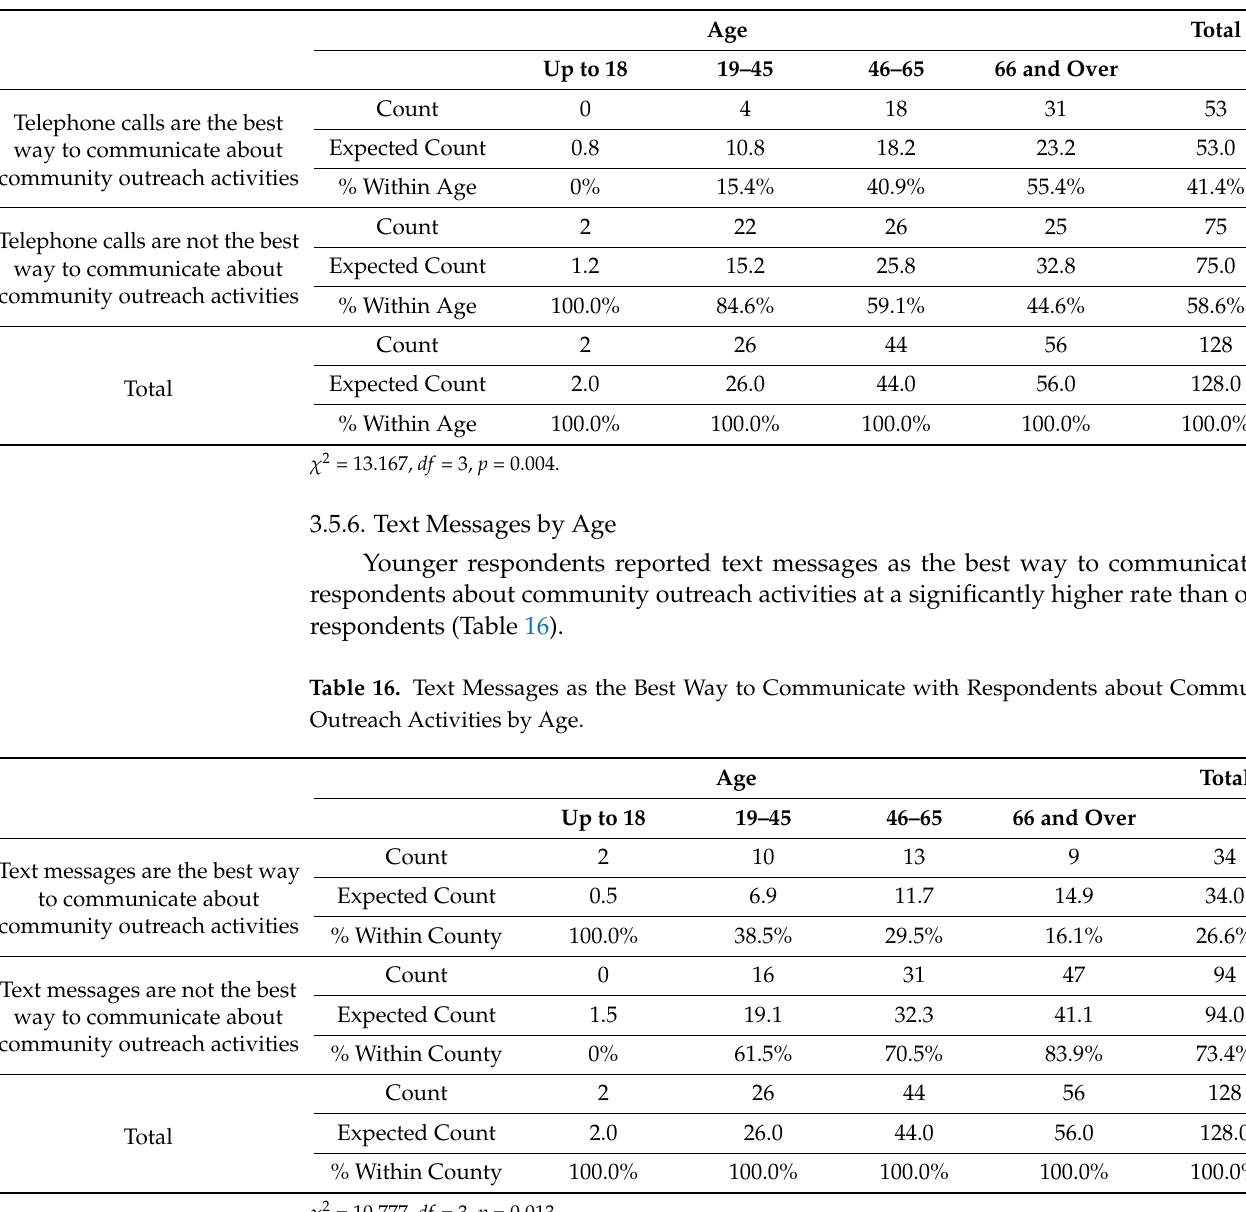
Table 15. Telephone Follow-Up Calls as the Best Way to Communicate to Respondents about Community Outreach Activities by Age.